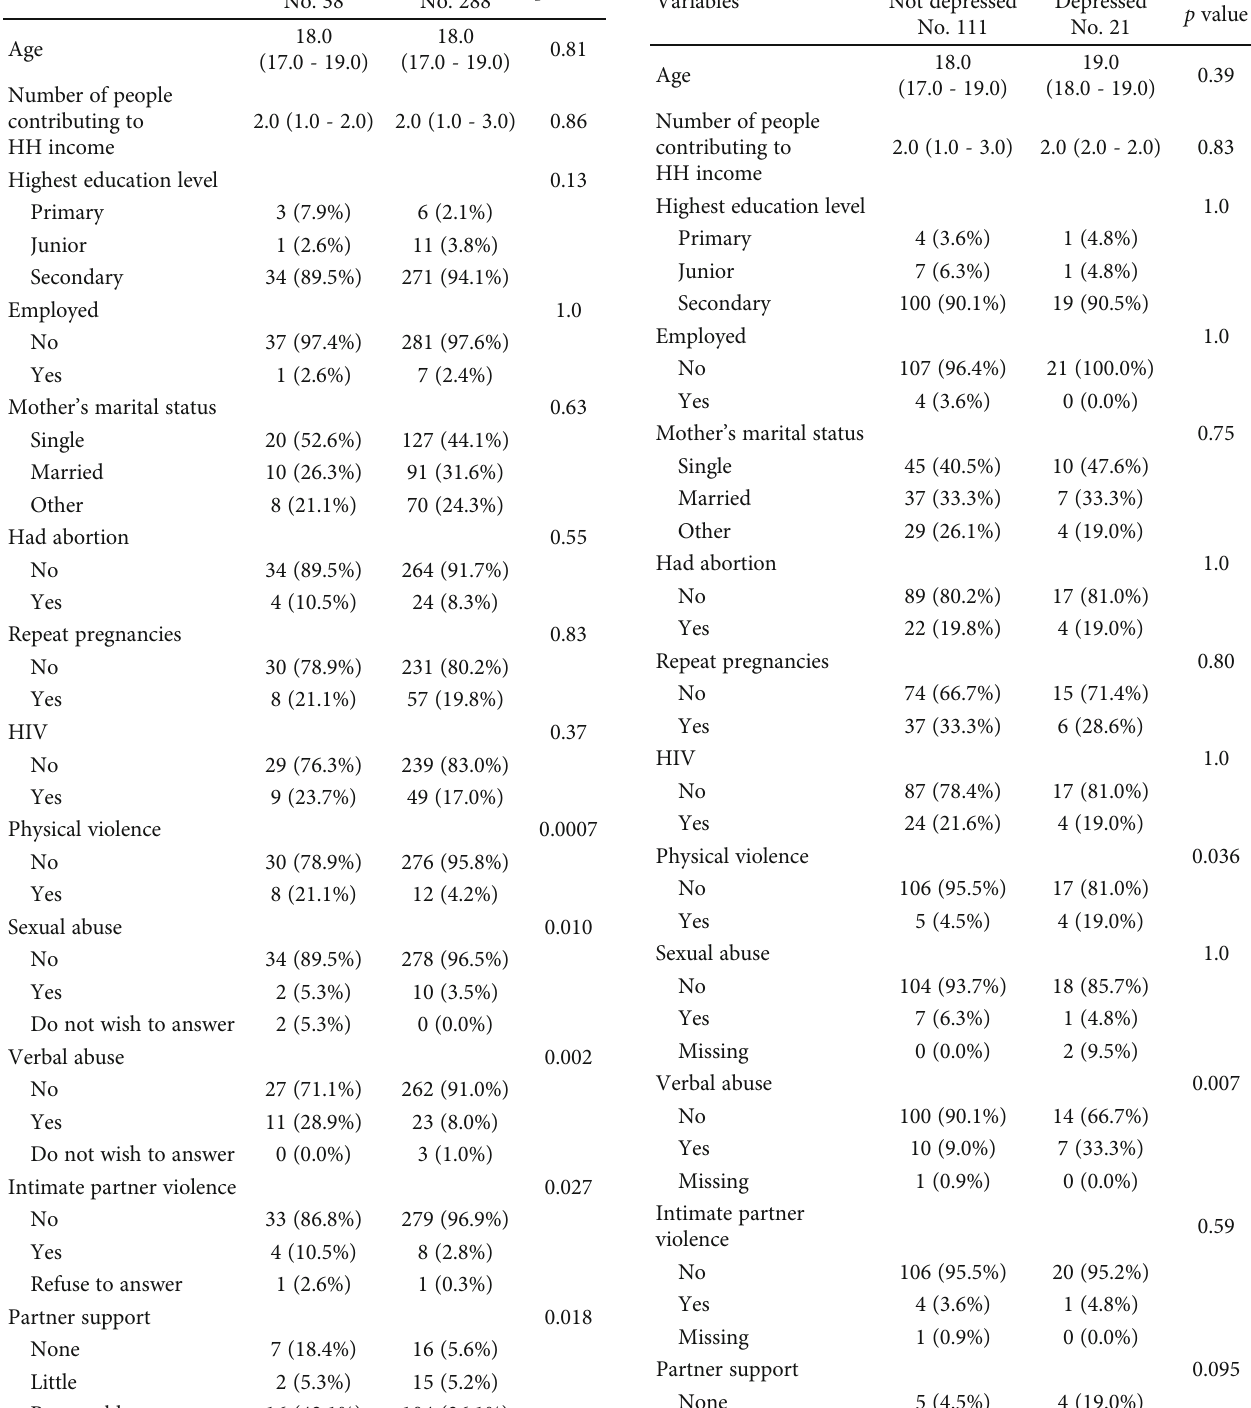
Table 5: Comparison of risk factors for participants who speci fi cally had depression versus those who did not in the prenatal period ( n = 132